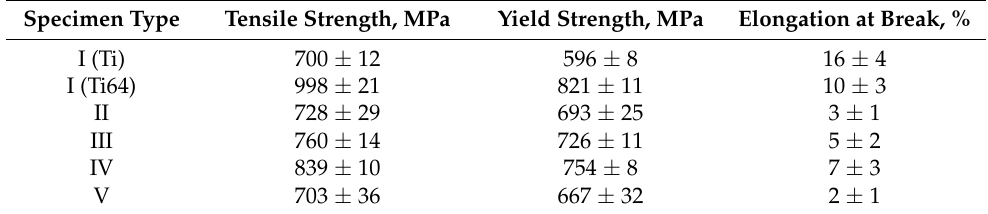
Table 1. The results of tensile tests of Ti, Ti64, and graded Ti/Ti64 samples produced by L-PBF with the subsequent HIP.